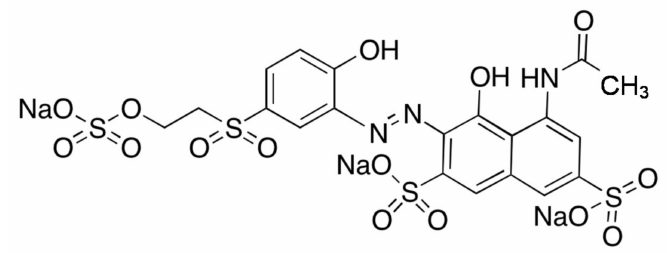
Figure 1. Chemical structure of azo dye Reactive Violet 5